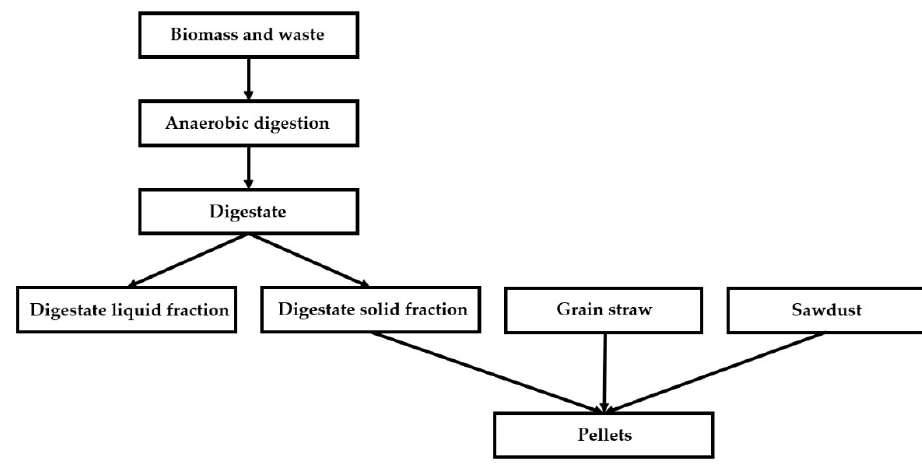
Figure 3. The scheme of the research methodology.